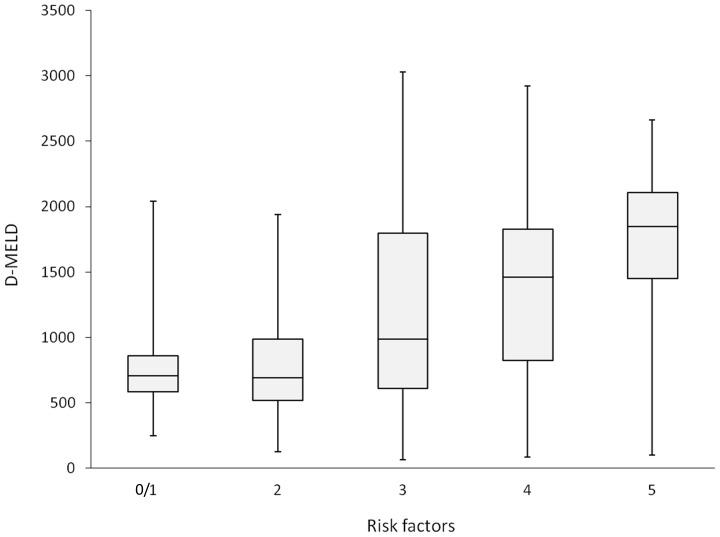
Box-Whisker-Plot depicting D-MELD scores for the number of positive risk factors in the patient collective.While there is an increase of median D-MELD-scores with an increasing number of risk factors, this is no significant correlation.